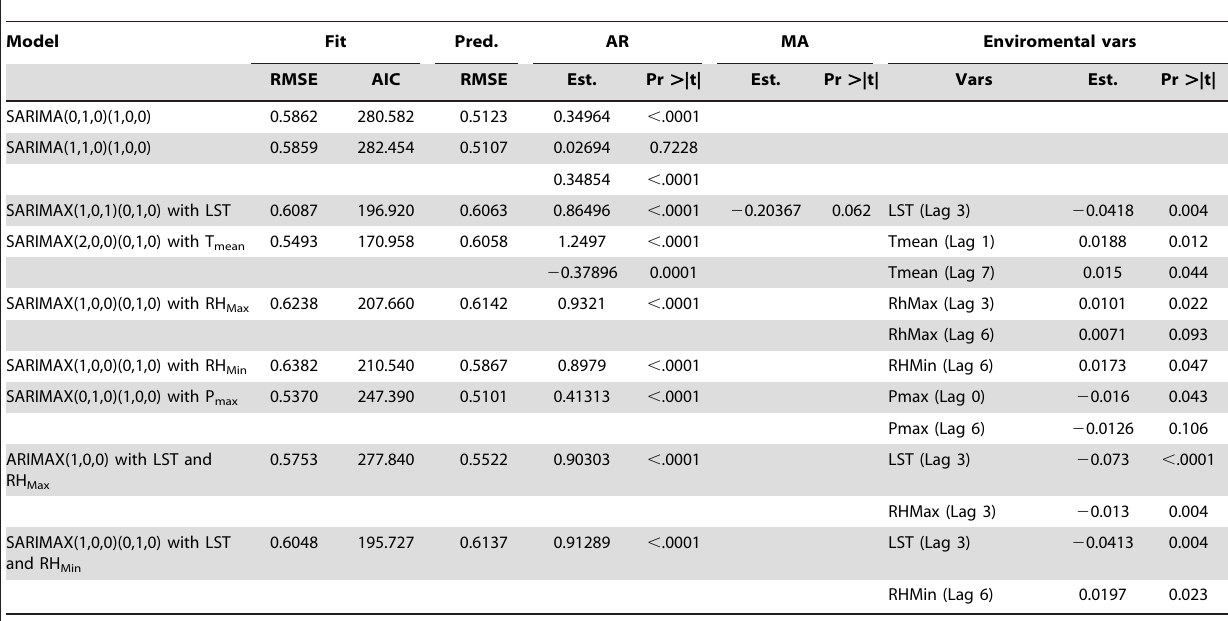
Table 3. Summary of model performances and the estimated coefficients for Maricopa County influenza.